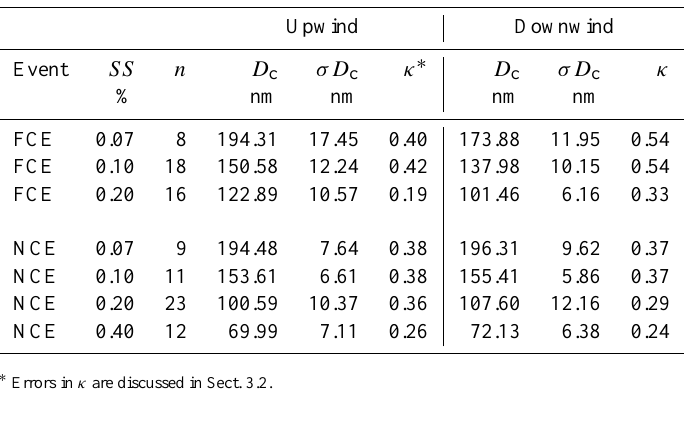
Table 2. Mean critical diameter ( D c ), standard deviation ( σD c ) and hygroscopicity parameter ( κ ) for full cloud events (FCE: 11.2, 11.3, 13.3, 22.0 and 22.1) and non-cloud events (NE_NCE: 0.1, 0.2, 0.3, 0.4 and 0.5) at the Goldlauter and Gehlberg stations, separated by supersaturation (SS). N gives the number of cases where measurements could be compared between Goldlauter and Gehlberg.